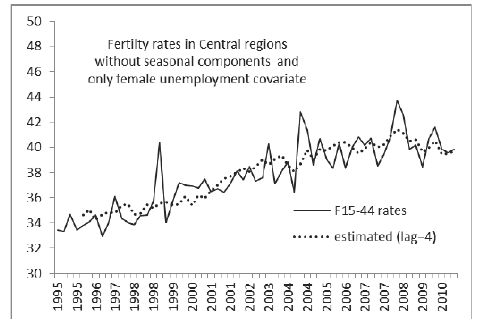
Figure 11 – Fertility rates in Central regions. Empirical and estimated values (model